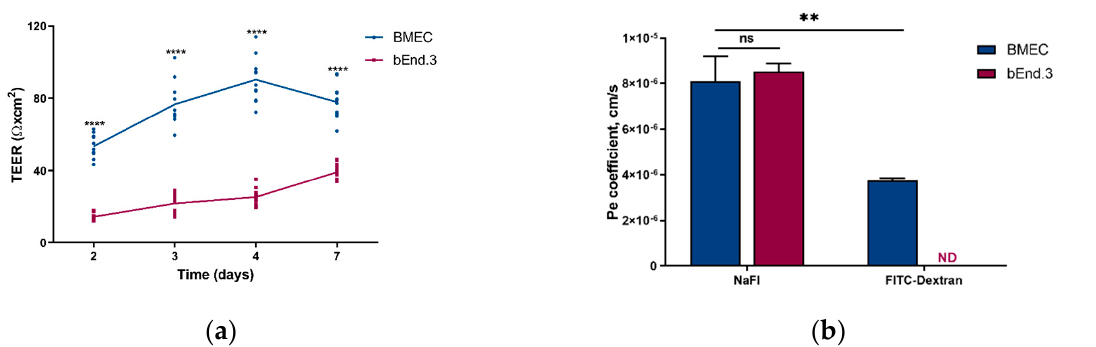
Figure 3. ( a ) Transendothelial electrical resistance (TEER, expressed as Ω × cm 2 ) and ( b ) endothelial Pe for sodium fluorescein (NaFl) and FITC-dextran (Pe, expressed in cm / s) of the blood–brain barrier models built from mouse primary brain endothelial cells (BMEC, blue) and from mouse brain endothelial cell line (bEnd.3, red) at day 7. All data are presented as means ± SD ( n = 12 for TEER, n = 4 for Pe). Statistical analysis: unpaired t test with Welch’s correction (ns: p ≥ 0.0332, **** p < 0.0001, ND-not detected).